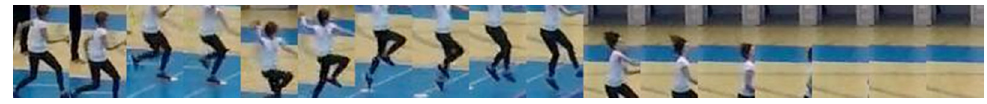
Figure 19. Tracking errors due to poor player detection.